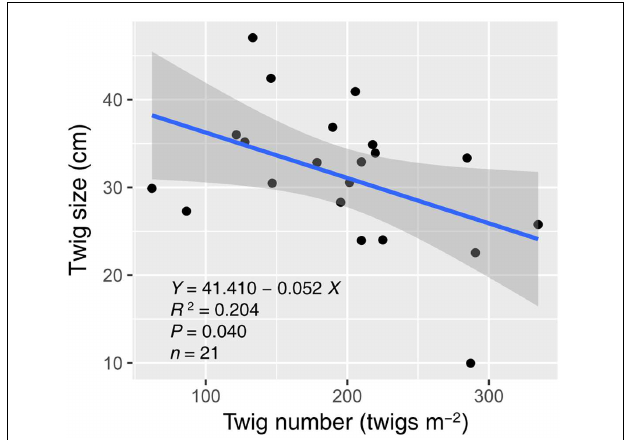
FIGURE 3 | Relationship between twig size and number of A. ordosica . The gray region indicates the 95% confidence interval around the regression. Three abnormal observations were removed prior to regression